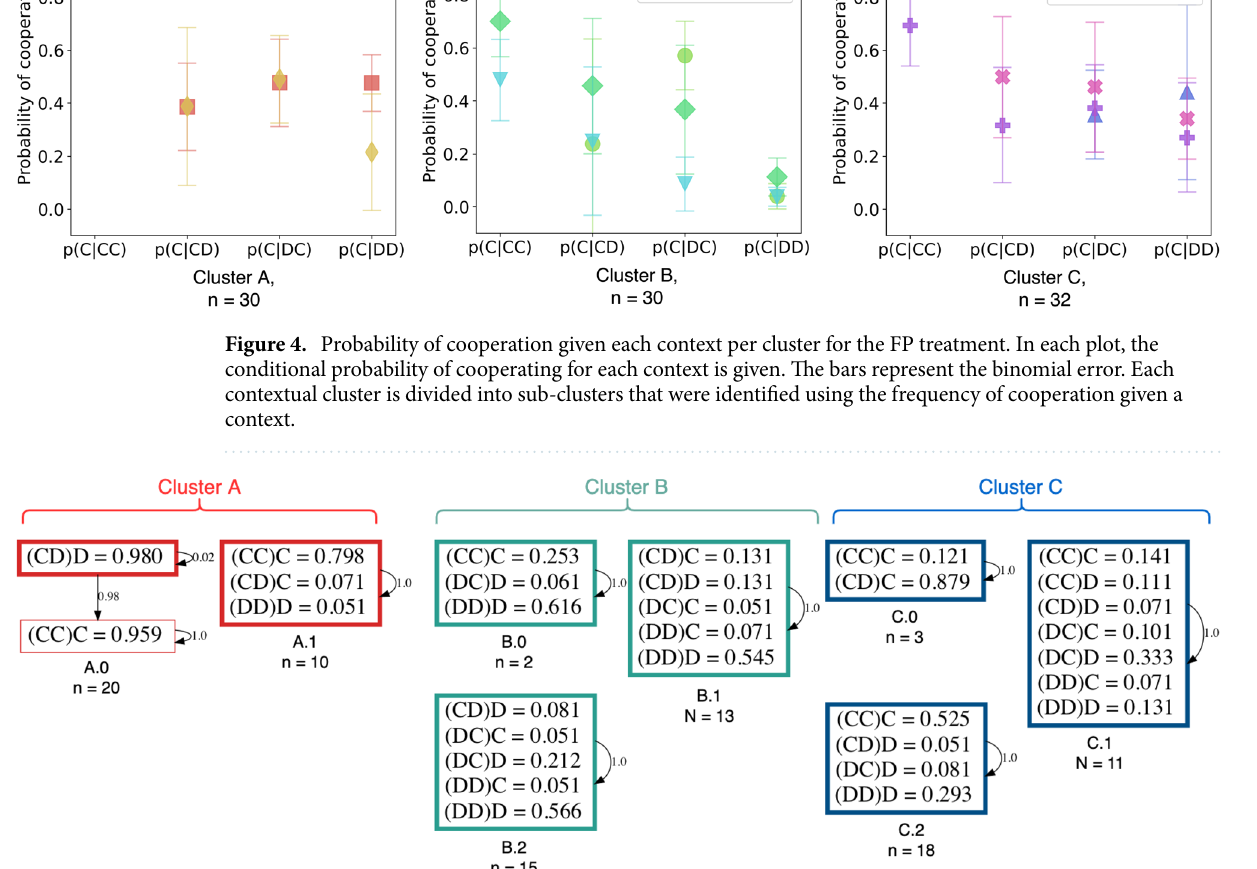
Figure 5. Hidden Markov Models for the FP treatment. Here, the eight sub-clusters found in FP have a HMM that describes each sub-cluster’s strategy for the data over all rounds. Bold rectangles represent the initial state, while the others represent subsequent hidden states. Symbols with a probability lower than 0.05 are not shown, as well as the transition probability between states lower or equal to